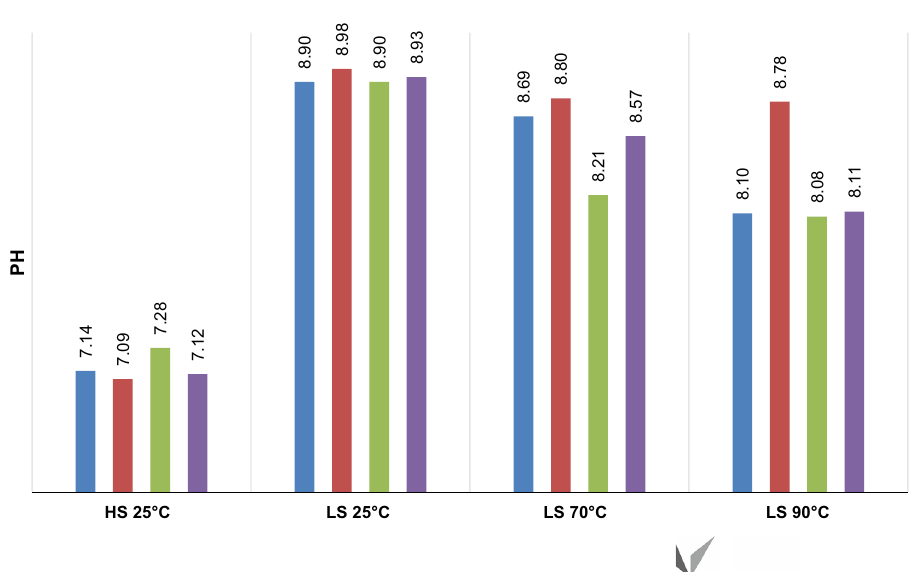
Fig. 11 Effluent pH comparison at 25, 70, and 90 °C for cores 1, 2, 3, and 4